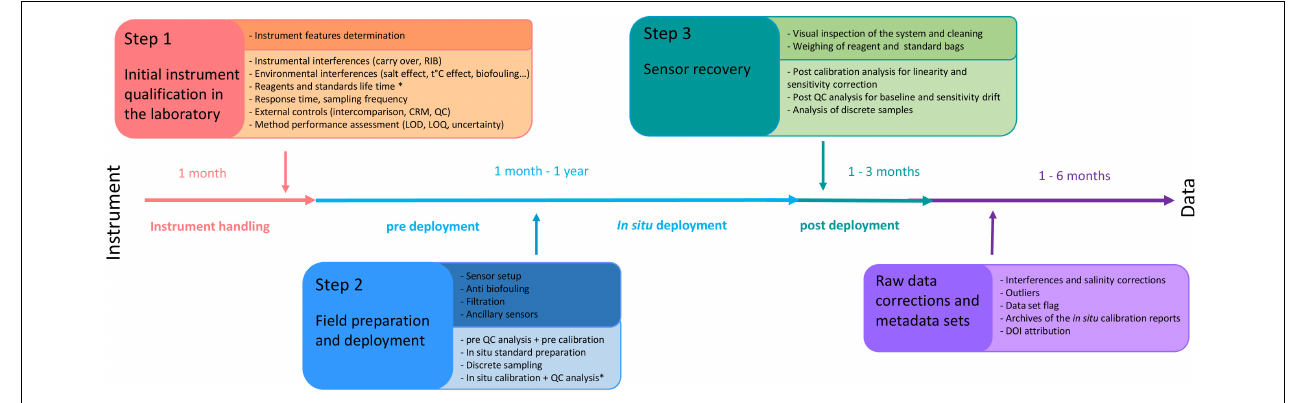
FIGURE 2 | Schematic workflow describing the various steps for using in situ nutrient sensors in seawater ( ∗ only for wet chemical